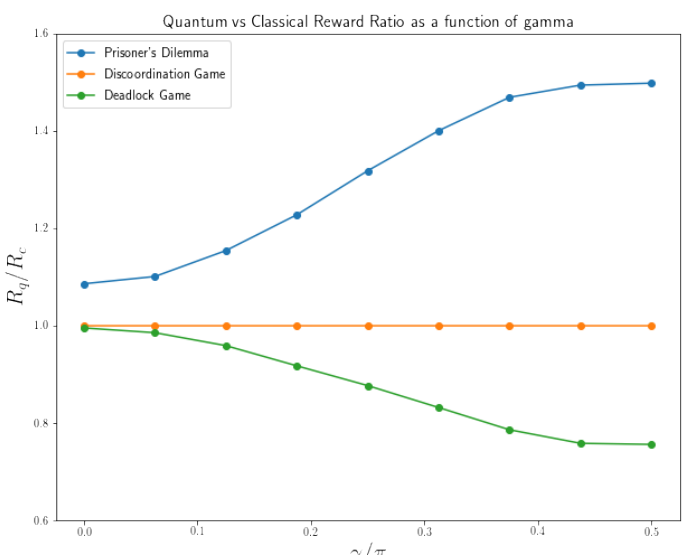
Figure 5. Quantum versus classical reward ratio as a function of the entanglement factor γ